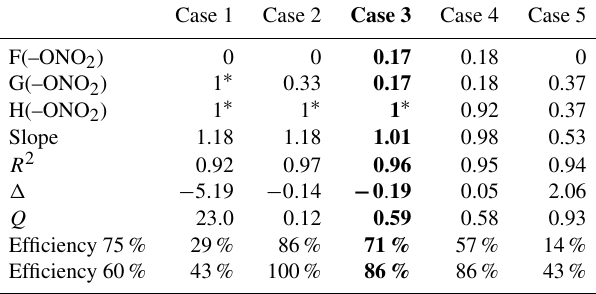
Table 3. SAR tests on organic nitrate parameters: five case tests evaluated the nitrate group influence. Constraints imposed are the following: values fixed to 1 (i.e., no influence on the reactivity) marked by *; F(–ONO 2 ) = G(–ONO 2 ) for case 3 and case 4; and G(–ONO 2 ) = H(–ONO 2 ) for case 5. In bold is the selected case. The slope is the correlation slope between the simulated and the experimental k OH rate constants, and R 2 is the corresponding cor- relation coefficient. The (cid:49) factor is the relative difference between the simulated and the experimental rate constant. Q is the sum of the square difference between calculated and experimental values nor- malized by the experimental uncertainties. Efficiencies at 75% and 60% represent the percentage of organic nitrates with | (cid:49) | < 0 . 25 and | (cid:49) | < 0 . 40, respectively.